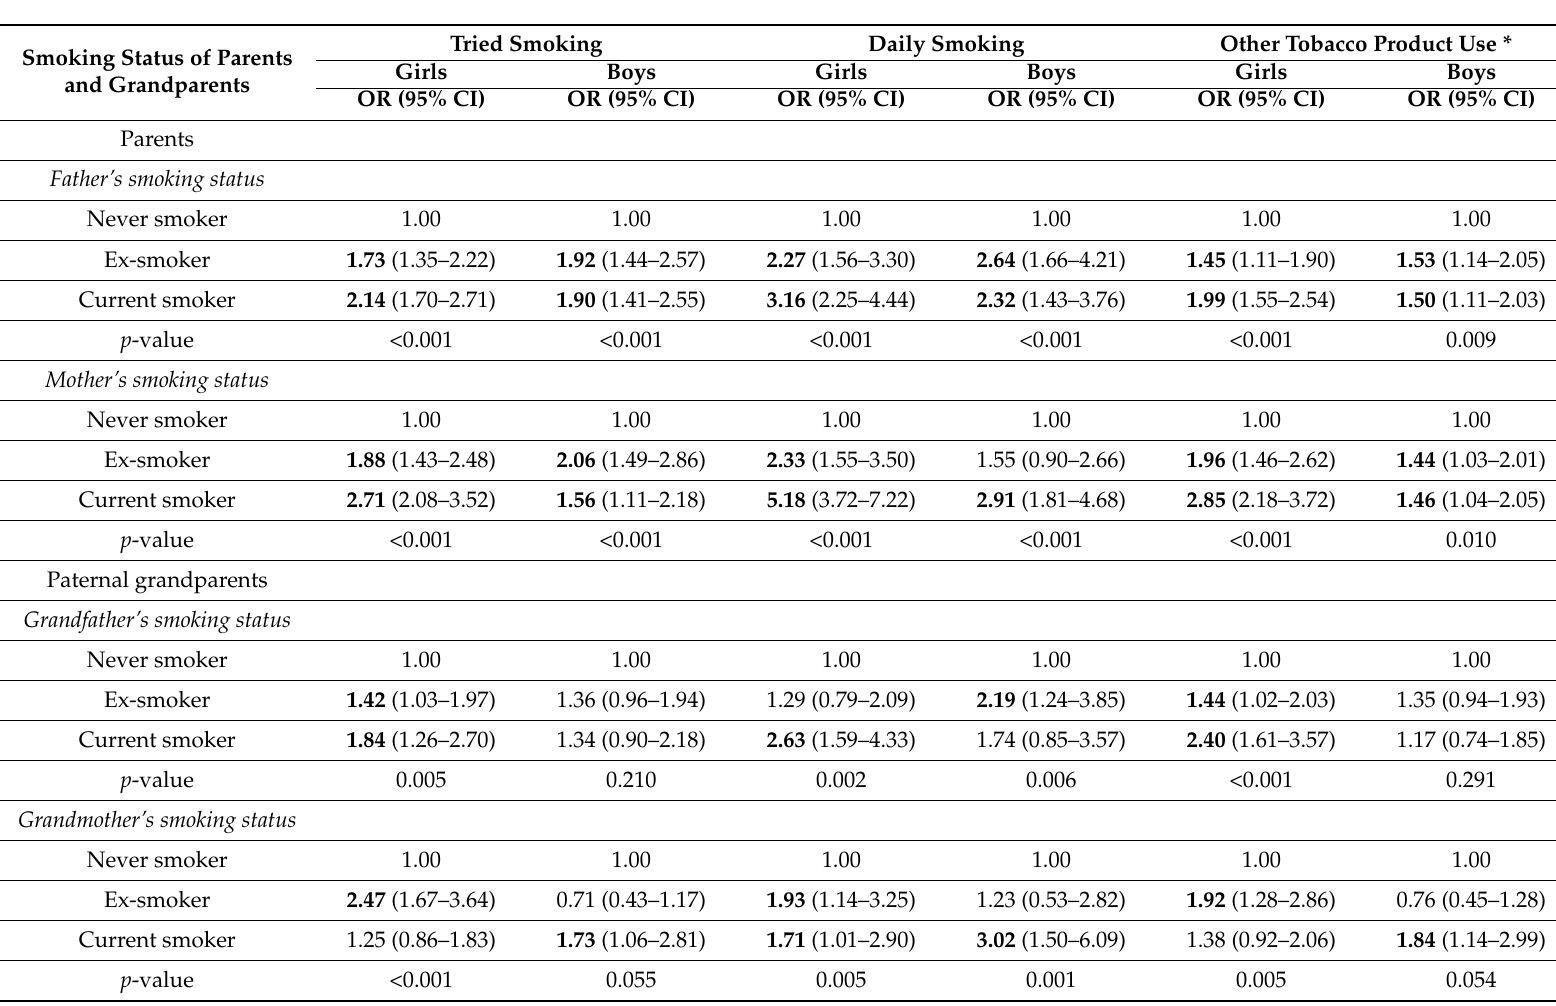
Table 2. Age-adjusted ORs and 95% CIs for boys’ and girls’ smoking experimentation, daily smoking and other tobacco product use * by parents’ and grandparents’ smoking